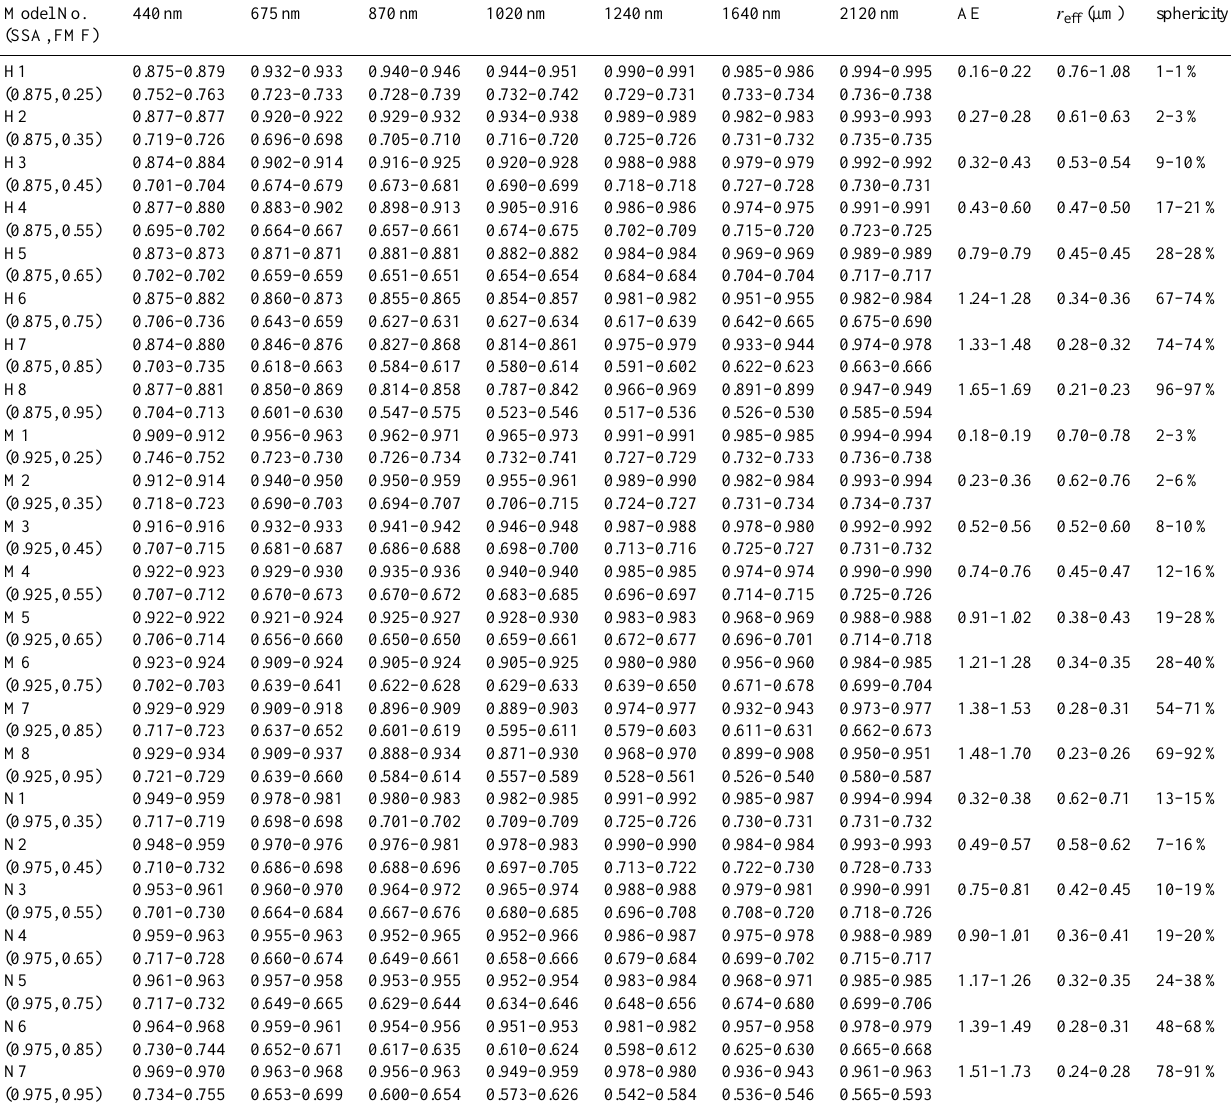
Table 2. Spectral SSA (upper) and asymmetry factor (lower) with respect to wavelength, ˚Angstr¨om exponent (AE), effective radius ( r eff ) , and sphericity of the new aerosol models used for the test algorithm. H models (0.85 < SSA < 0.90) and M models (0.90 < SSA < 0.95) cover FMF ranging from 0.2 to 1.0, while N models (SSA > 0.95) cover from 0.3 to 1.0. The minimum and maximum values are shown because of AOD dependence. The optical properties are interpolated to spectral response functions of MODIS bands in RTM calculations. Model No. 440nm r eff (µm) (SSA, FMF)